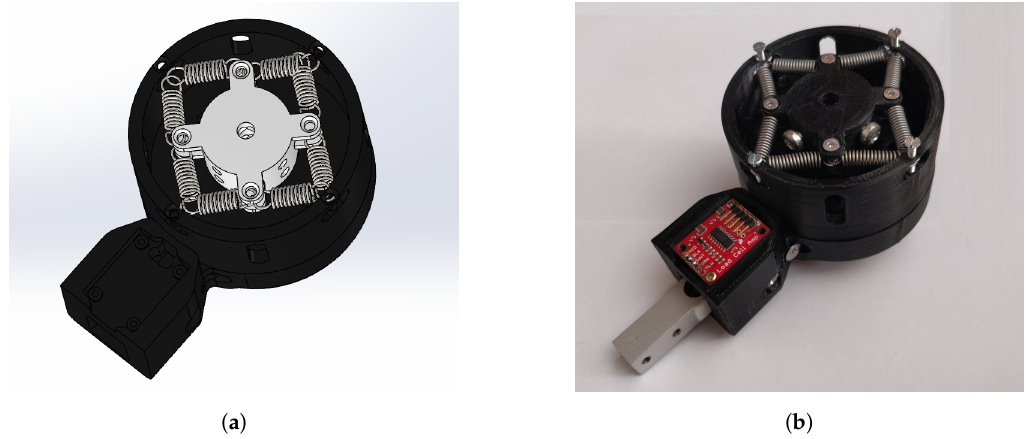
Figure 2. CAD representation and real joint (v7). ( a ) Render of joint (v7); ( b ) Real joint (v7).